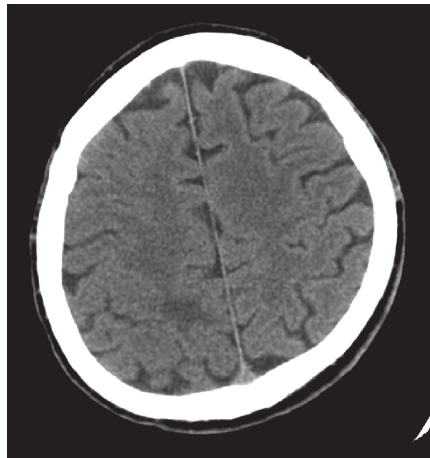
Figure 6: Axial CT image of the brain with a hypodense lesion in the right parietal lobe, surrounded with oedema.